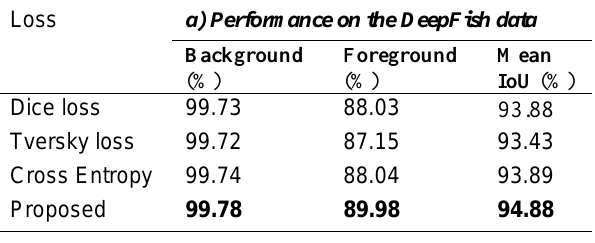
Figure 6. Representative fish segmentation results by the proposed model when trained with different losses